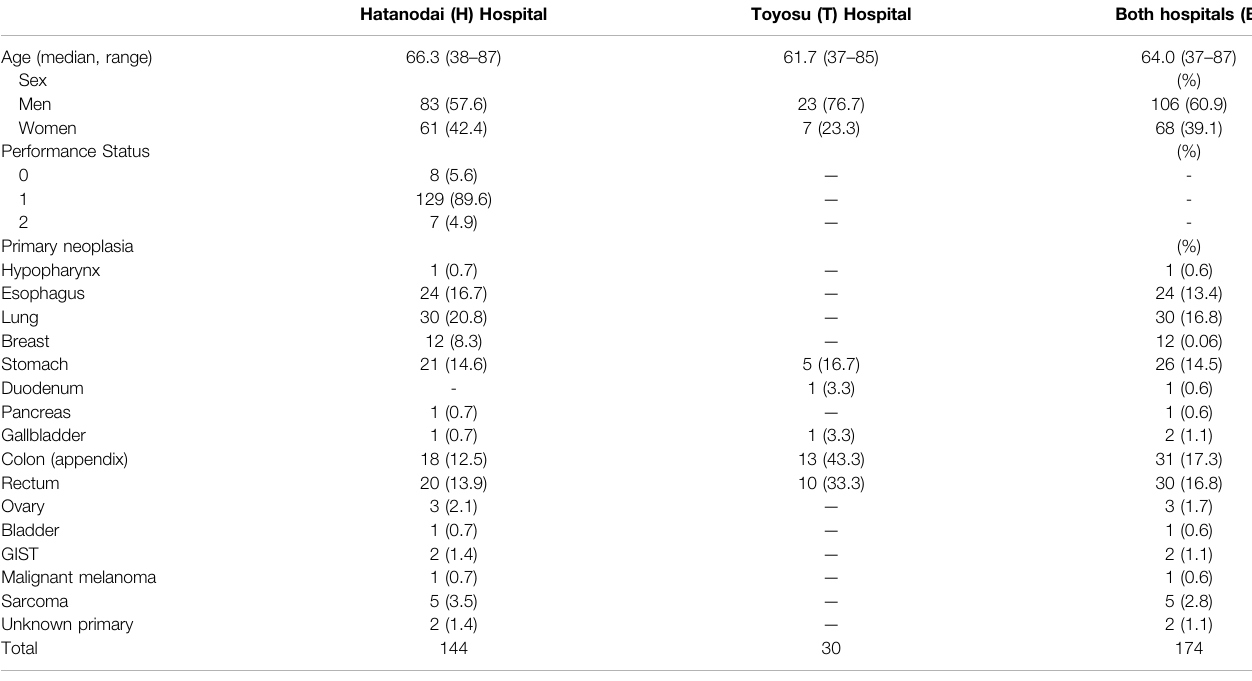
TABLE 1 | Demographic data and malignancy locations.